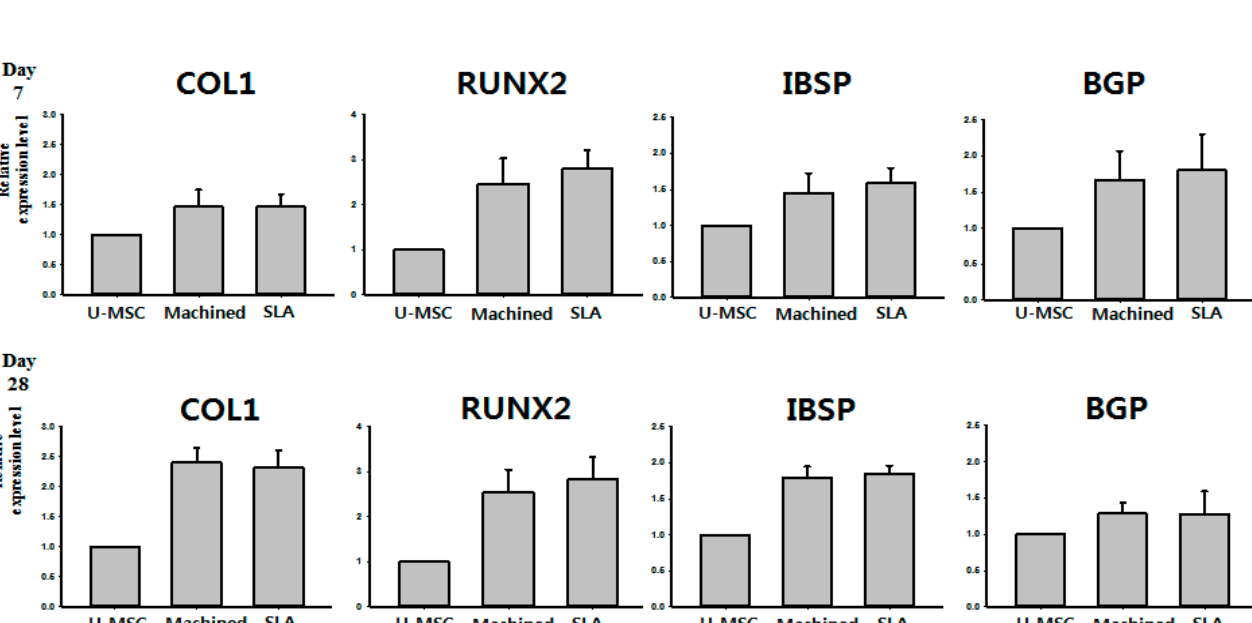
Figure 5. Molecular quantification of osteogenic differentiation of d-hMSCs on either cell plate (undifferentiated MSC, U-MSC), machined (machined) or SLA-treated surface (SLA) titanium discs.